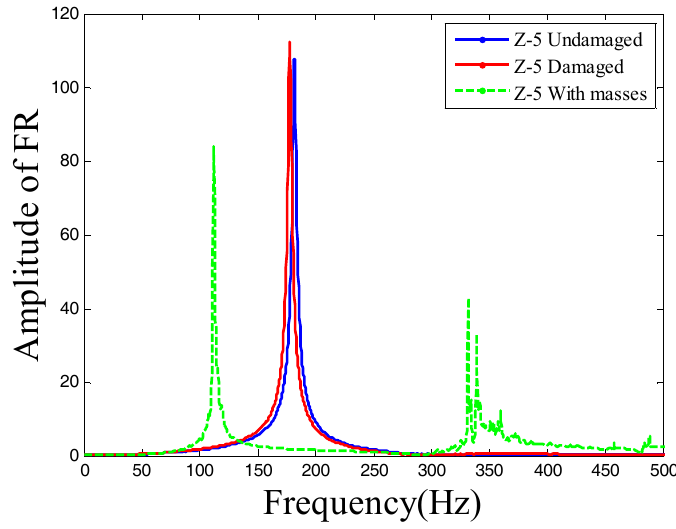
Figure 10. Substructure 5: Frequency changes before and after damage.